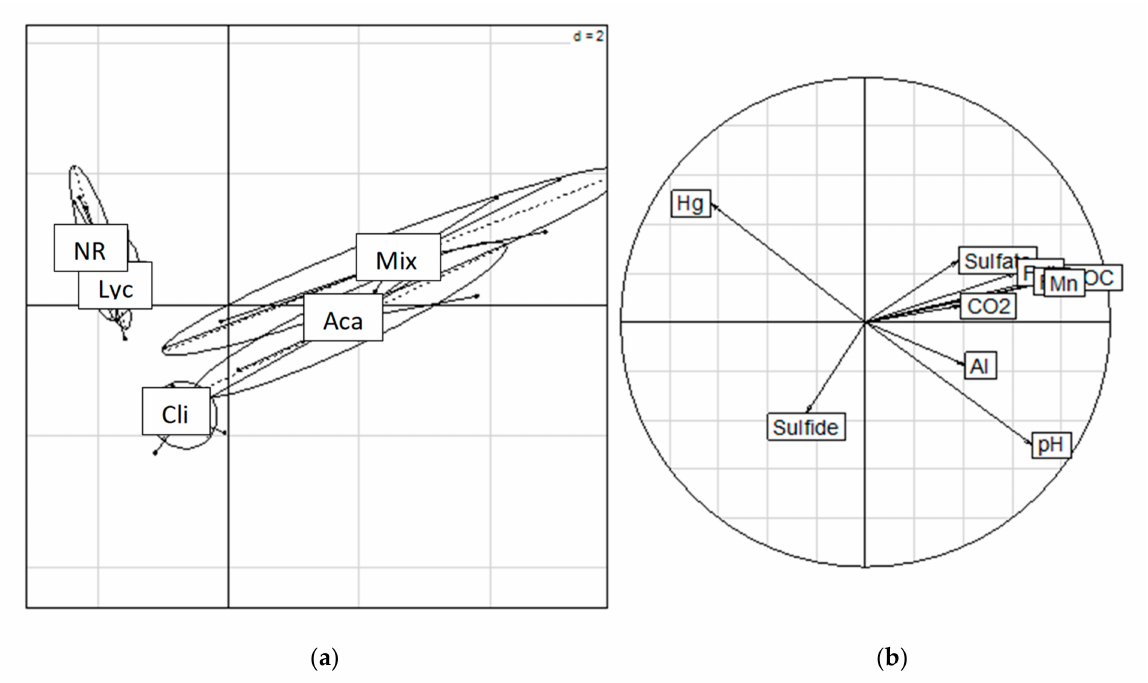
Figure 5. Principal component analysis (PCA) on the data monitored during the anaerobic experiment with types of vegetation cover. Left ( a ): projection of data set variability plotted on a factorial map of the first two discriminating axes according to respective Labels on the gravity center correspond to the types of vegetation cover: NR. Non-Restored with only spontaneous vegetation, Lyc. Lycopodiella sp , Cli. C. racemosa , Aca. A. mangium , Mix: Mixed fabaceous culture. To sub-factor of respective factor. Right ( b ): correlation circles plot with variable vectors (pH, CO 2 , DOC, SO 42 − , S 2 − , Fe (II), Fe, Al, Mn, Hg) for each respective factor. Eigen values 54.4% and 17.5% for axes 1 and 2, respectively. Rand test: simulated p -value: 0.001. Explained variance: